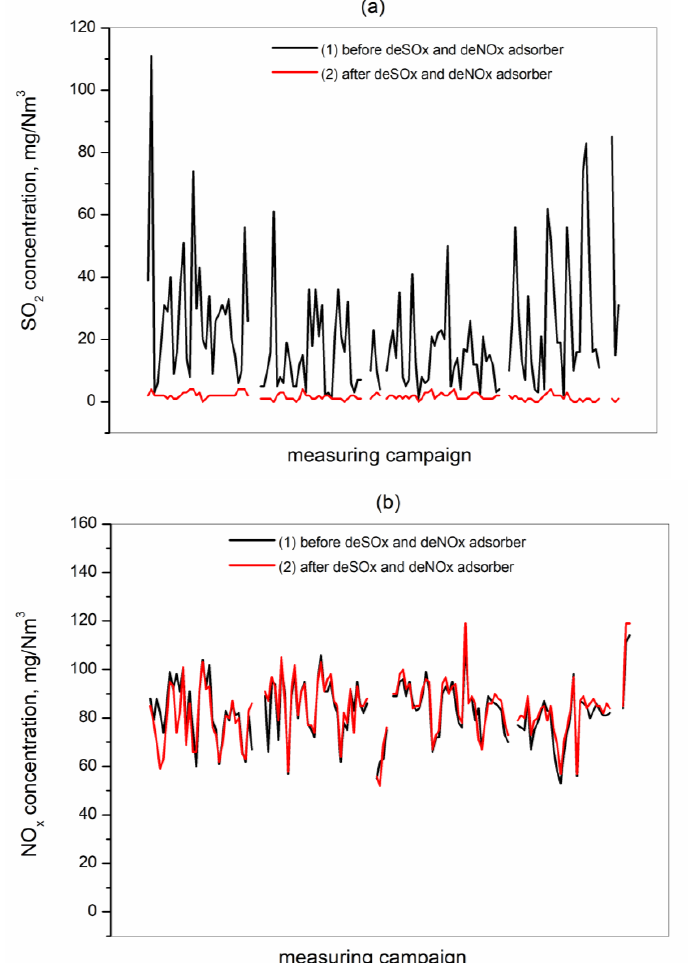
Figure 9. Online analysis of SO 2 concentration ( a ) and NO x concentration ( b ) in the flue gas before and after leaving the deSO x and deNO x adsorber (the temperature of the CFB flue gas was 25 °C, the maximum capacity of the DR-VPSA installation was 100 Nm 3 /h, the measuring campaign was 808 h).